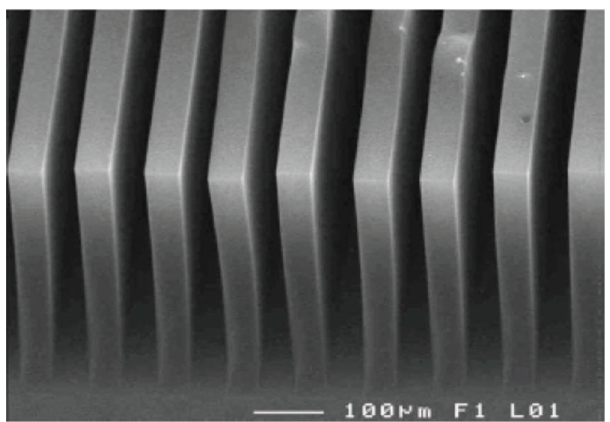
Figure 2. As-grown CNT cooling fins used to cool down the power transistor. Reprinted with permission from [3].